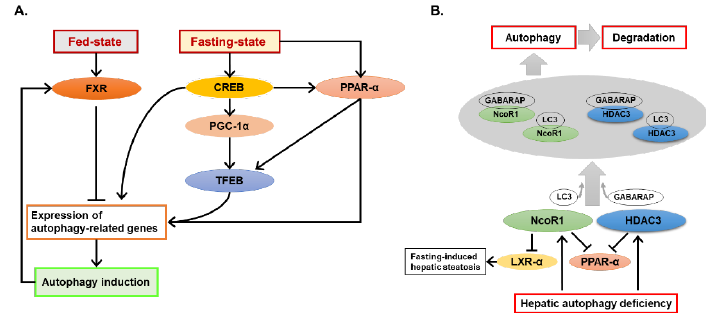
Figure 1. Crosstalk of autophagy and nutrient-sensing nuclear receptors. ( A ) Roles of nutrient-sensing nuclear receptors in autophagy regulation under the fasting and fed states. Feeding-induced farnesoid X receptor (FXR) activation inhibits the expression autophagy-related genes and thus suppresses autophagy. In fasting status, cAMP response element-binding protein (CREB) and peroxisome proliferator-activated receptor alpha (PPARα) are activated. Both of them can induce expression of autophagy-related genes directly or indirectly by activating transcription factor EB (TFEB), and therefore activate autophagy. Conversely, FXR is suppressed in Atg7 -deleted livers and is associated with Atg7 deletion-induced cholestasis. Autophagy may thus be important in sustaining the expression and function of FXR. ( B ) Nuclear receptor corepressor 1 (NCoR1) and histone deacetylase 3 (HDAC3) are two PPARα suppressors. Both of them can bind to GABA type A receptor-associated protein (GABARAP) and microtubule-associated proteins 1A/1B light chain 3 (LC3) with a higher affinity to GABARAP, and then be degraded by the autophagy process. In mice with liver-specific loss of Atg7 , liver X receptor alpha (LXRα) can be inhibited by accumulation of NcoR1, which is associated with decrease of fasting-induced lipid droplet formation in these mice.